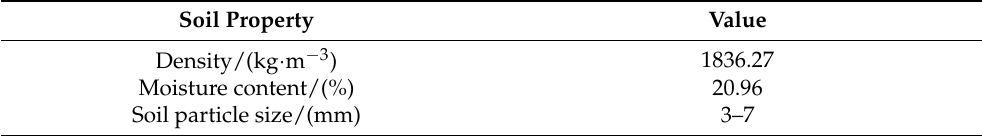
Table 2. The basic properties of